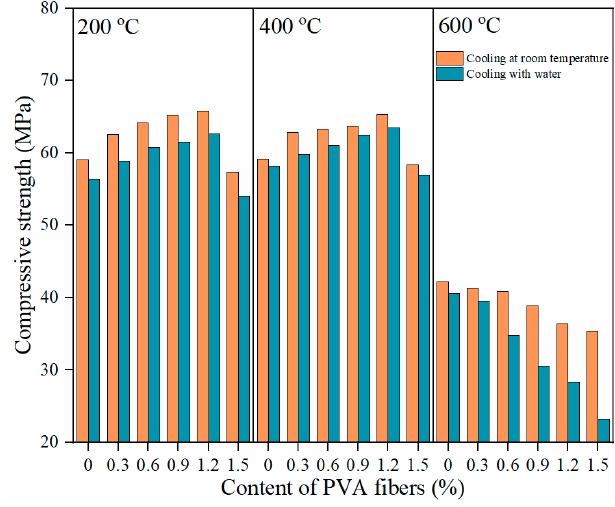
Figure 6. Compressive strength of PVA-FRCC specimens subjected to different cooling methods.